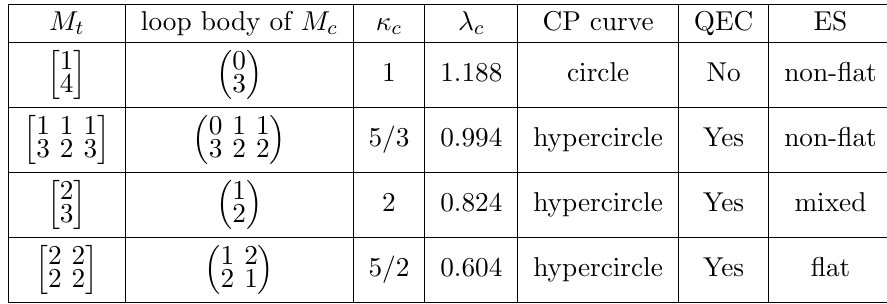
Table 1 . Properties about CP and entanglement for di(cid:11)erent tensor constraints in f 7 ; 3 g tiling. The meaning of the last two columns will be given in next two sections.